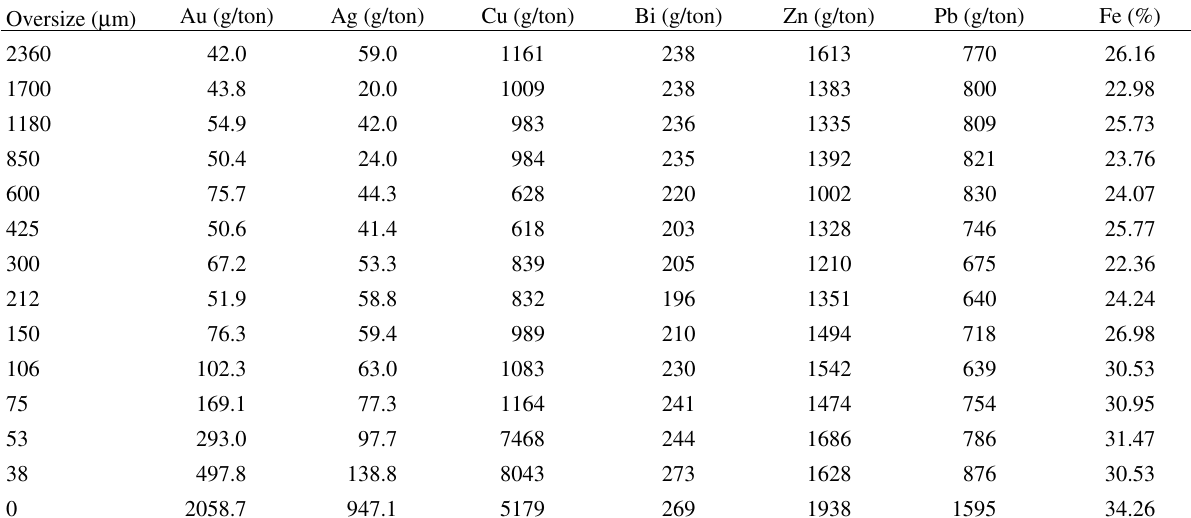
Table 2. Chemical composition of several product